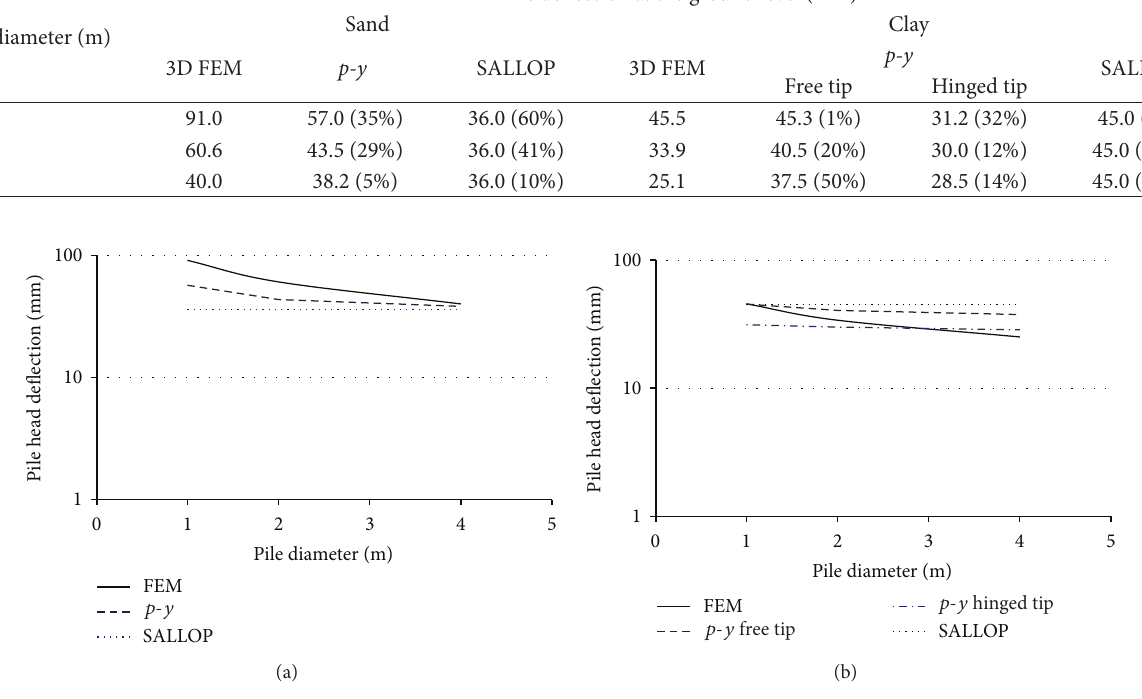
F 6: Variation of pile head displacement versus pile diameter in nonlinear analyses for (a) sand and (b) clay with constant EI for the